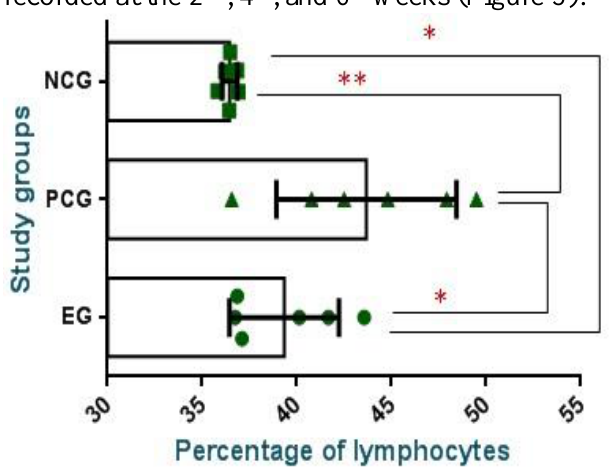
Figure 5. Total results of lymphocytes among the experimental groups and the time points. (*) and (**) referred to significant differences between groups as P≤0.05 and P<0.01 respectively.